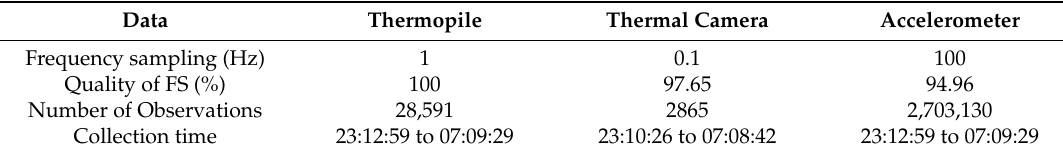
Table 2. Description of the collected data.